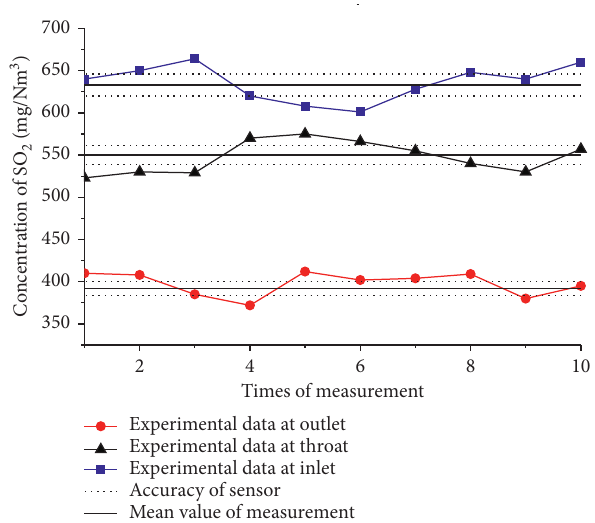
Figure 7: The value of